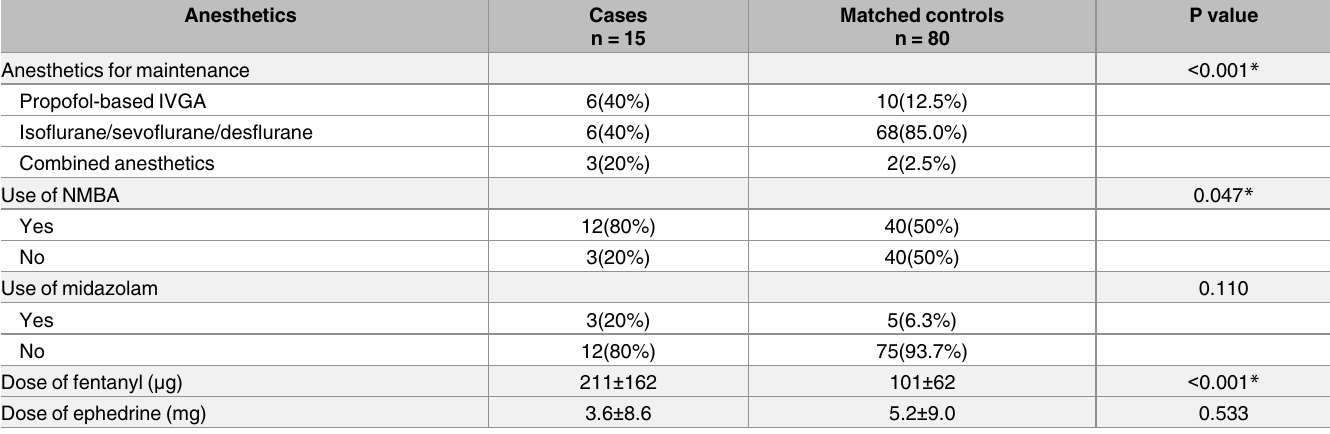
Table 4. Anesthetic-related factors for intraoperative awareness (casesvs matched